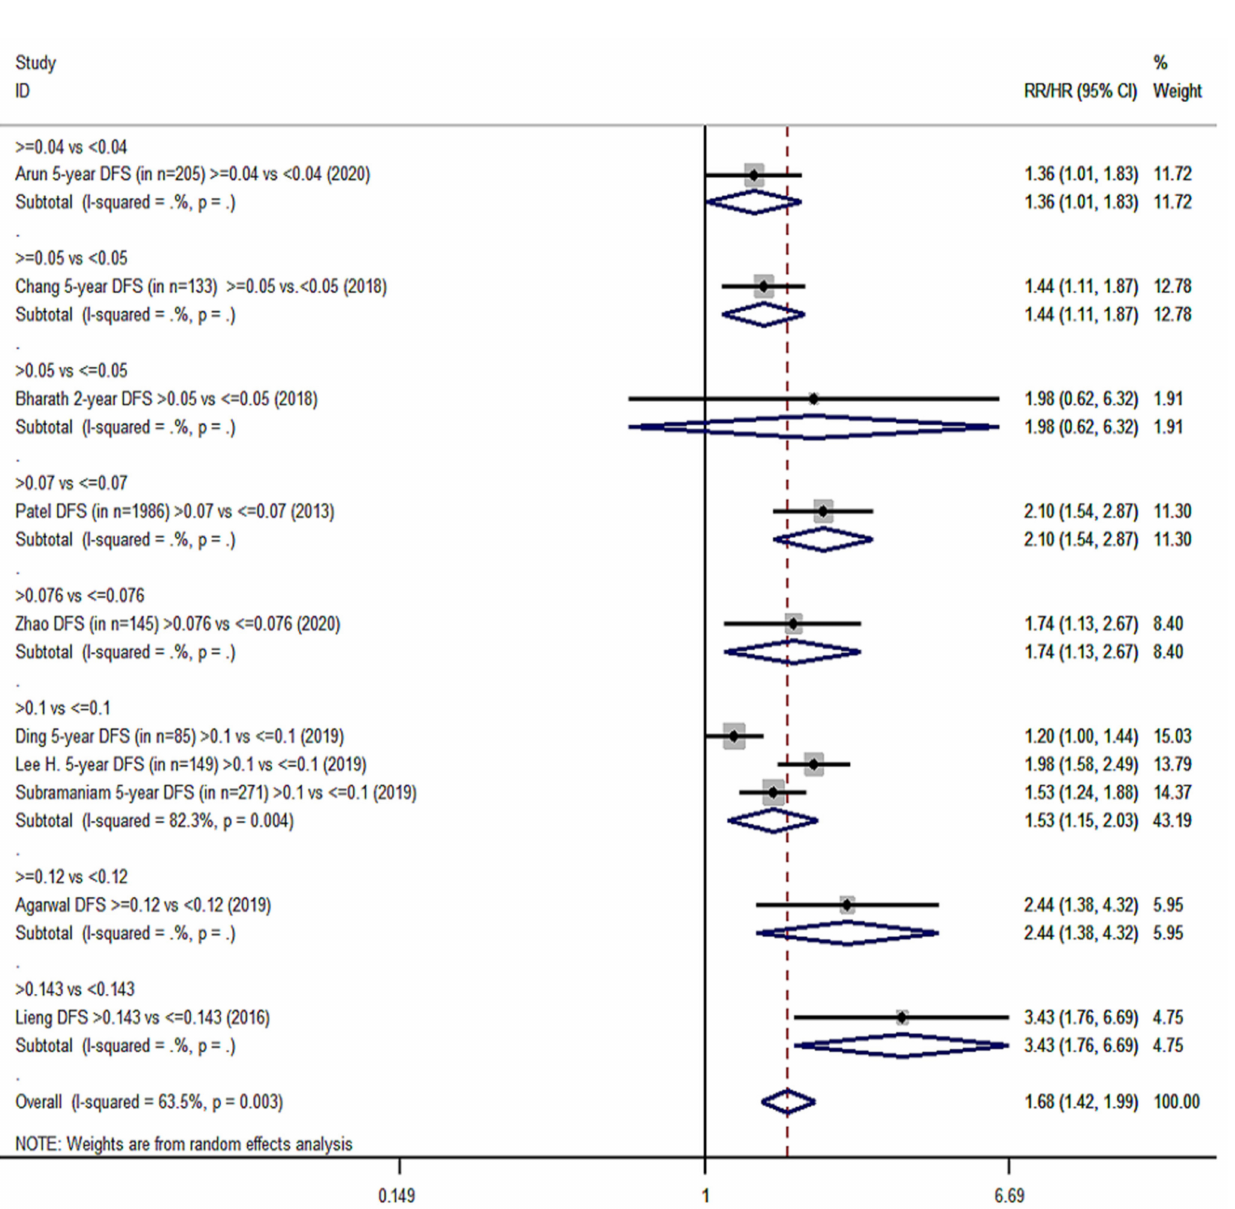
Figure 3. Forest plot demonstrating the associations between lymph node ratio (LNR) and disease- free survival (DFS) in group YES. Apart from the overall analysis, the subanalyses by LNR cut-off values are